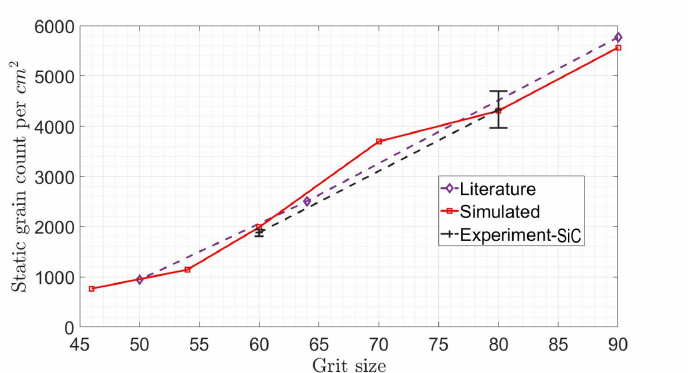
Figure 29. Comparison of simulated static grain count values with measured values from experiments and the literature [23].